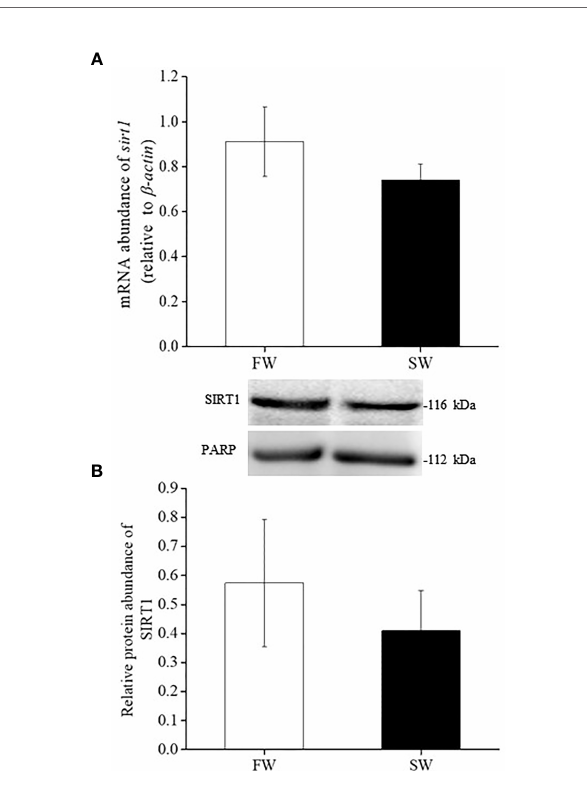
FIGURE 6 | The effect of SREBP-1 knockdown on mRNA expression of targeted genes in livers of fresh water (FW)- and seawater (SW)-acclimated Indian medaka. mRNA expression was analyzed by real-time PCR. Values are mean ± S.E.M. (N = 6). Student ’ s t-test, *p <